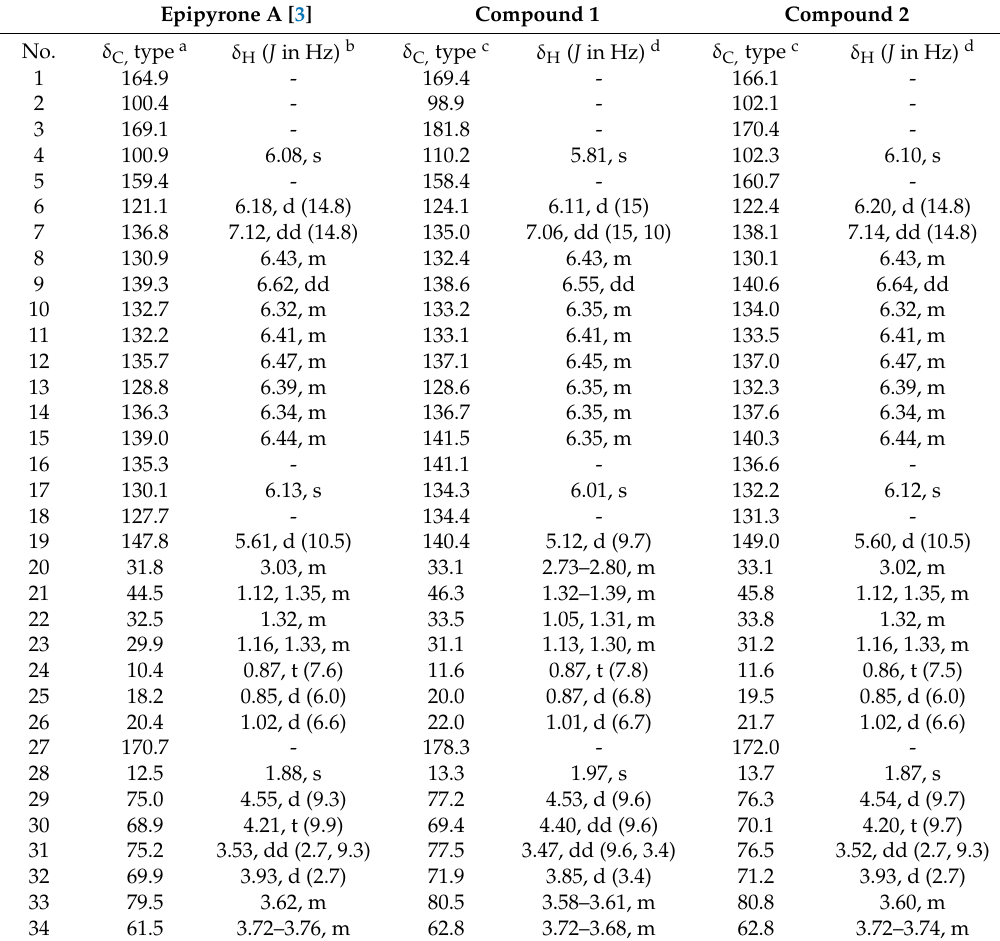
Table 3. Comparison of 1 H and 13 C NMR data of the yellow antifungal compound 1 purified